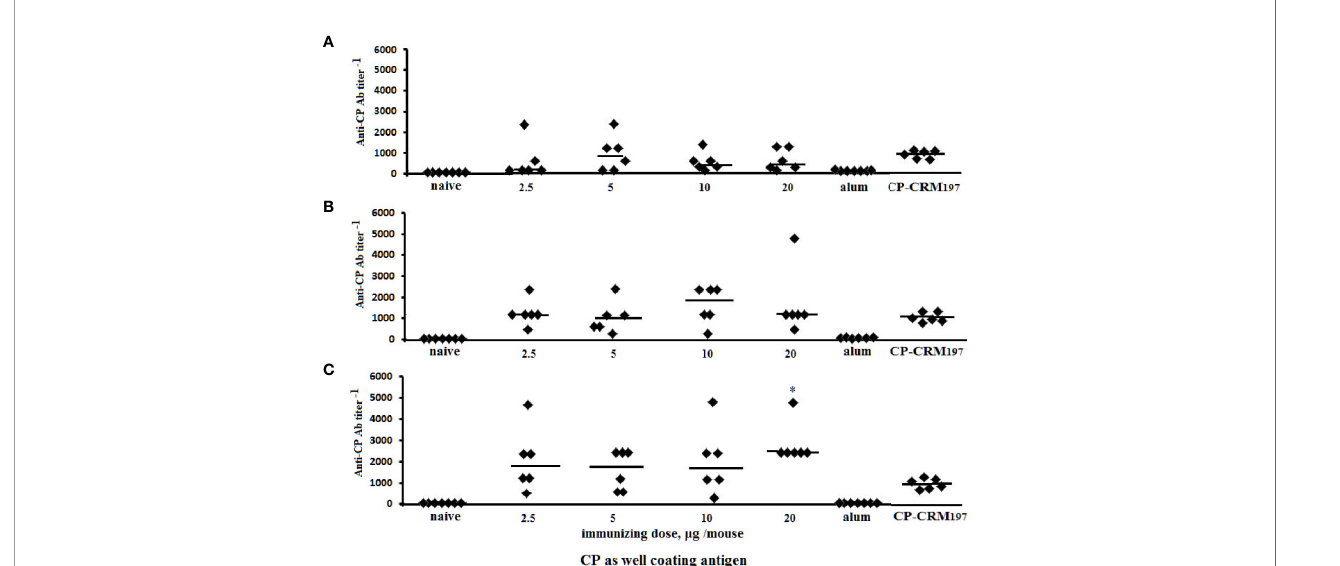
( Figure 8 ). Binding reactions were inhibited by adding the di-, tri-, and tetrasaccharide ligands and CP to the immune sera.